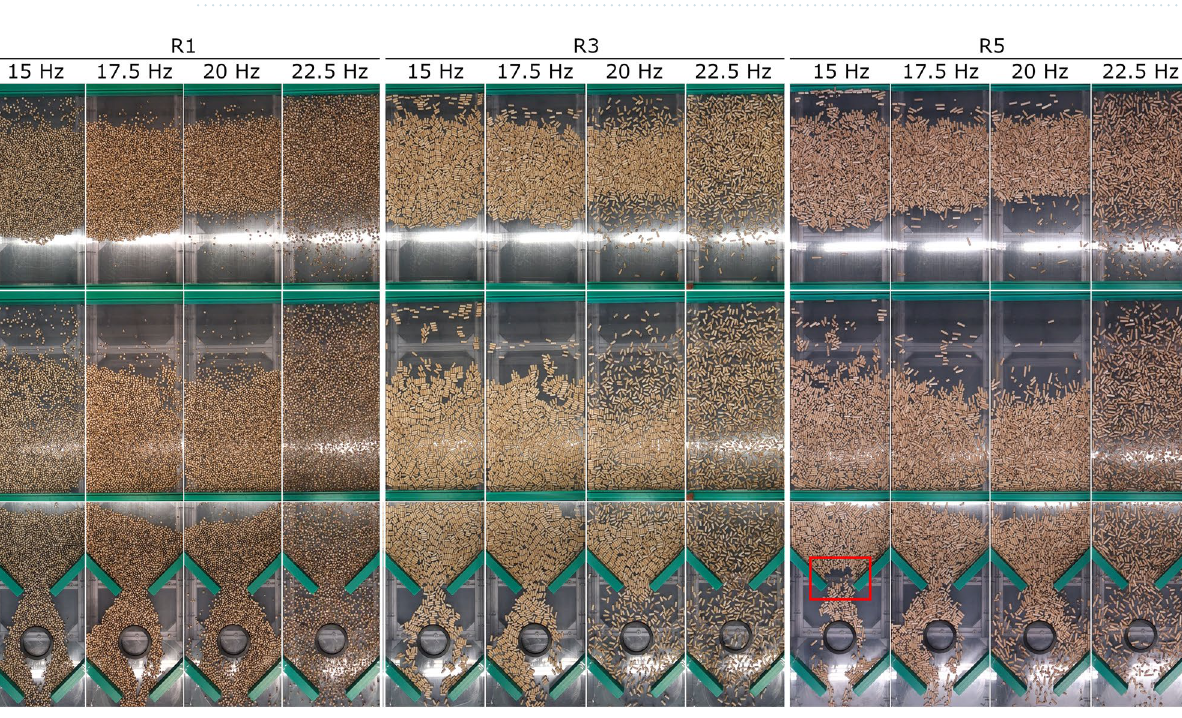
Figure 19. Pattern formation in real-time measurements of the transport speed of wooden rods, depending on the frequency of vibrations and the length of the